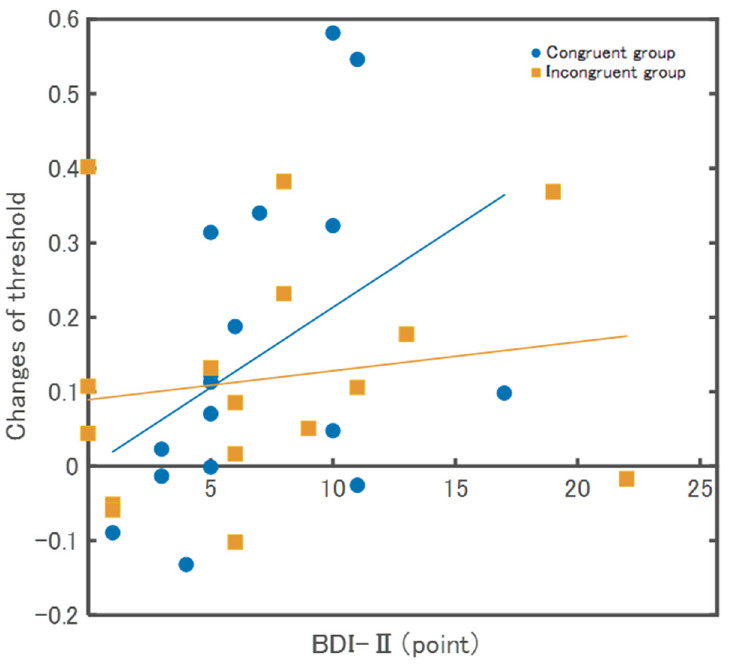
Figure 5. Results of correlation between changes of threshold and BDI-II. The Congruent group showed a significant positive correlation ( ρ = 0.52, p = 0.03), whereas, in the Incongruent group, there was no significant correlation ( ρ = 0.13, p = 0.62).